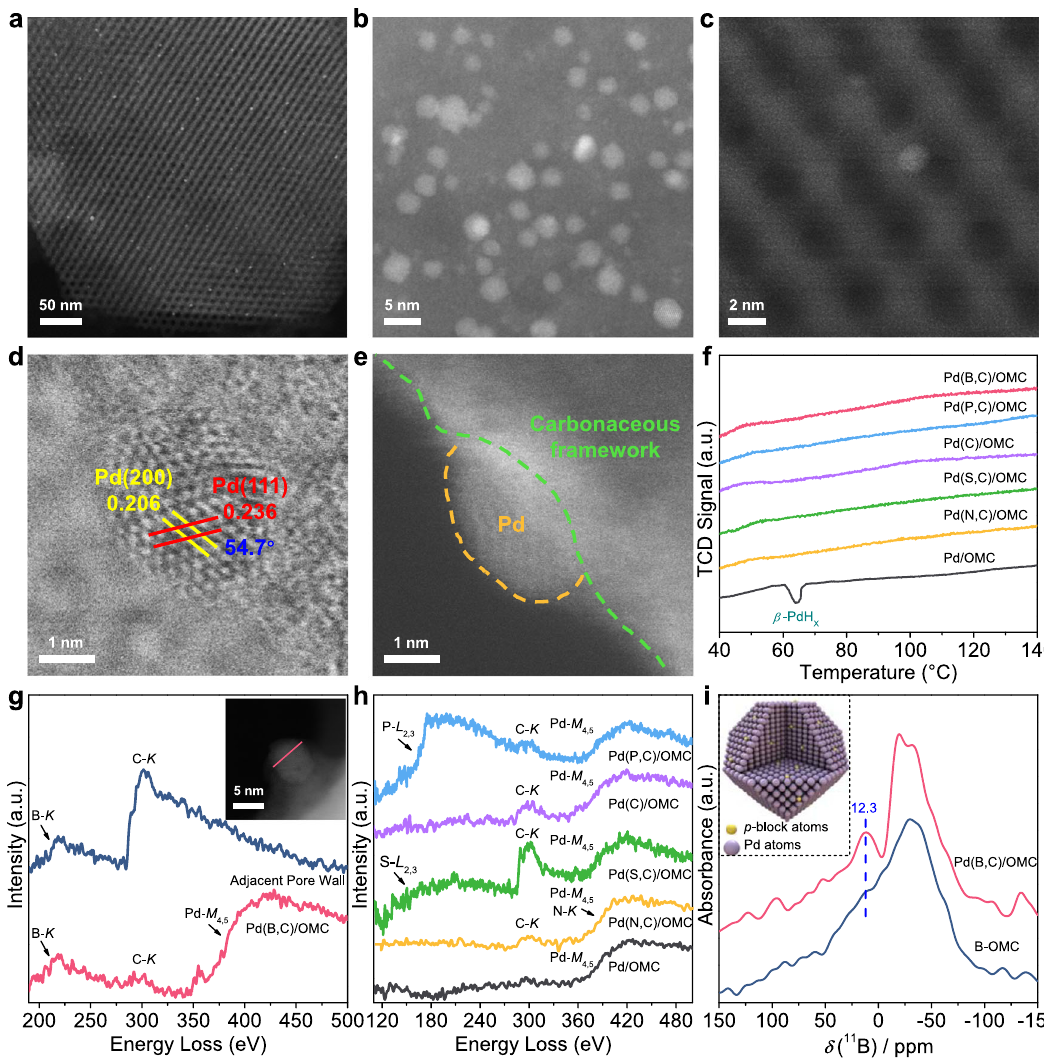
Fig. 1 Structure of Pd nanocatalysts. a – c Representative AC-ADF-STEM images, d AC-ABF-STEM image, e high-resolution SE-STEM image in STEM mode for Pd(B,C)/OMC. f TPHD curves for Pd interstitial nanocatalysts with different interstitial atoms and Pd/OMC reference catalyst without interstitial atoms. g EELS spectra for Pd(B,C)/OMC. For reference, the EELS spectrum for adjacent carbonaceous pore wall is also provided. Inset in g is the line scanning for a selected Pd nanoparticle. h EELS spectra for interstitial Pd nanocatalysts containing P/C, C, S/C, and N/C. For reference, the EELS spectra for pure Pd/OMC are also provided. i 11 B solid-state NMR spectra of Pd(B,C)/OMC (red line) and B-OMC without Pd (navy line). Inset is the schematic of Pd nanoparticles modi fi ed with p -block